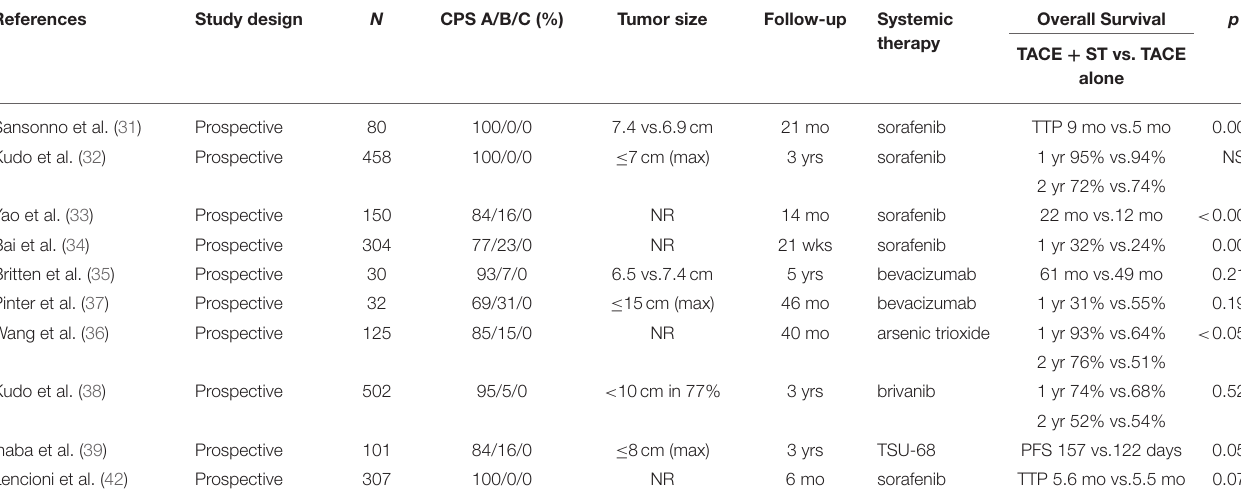
TABLE 3 | Studies of transcatheter arterial chemoembolization plus systemic therapy vs. transcatheter arterial chemoembolization alone for hepatocellular carcinoma.